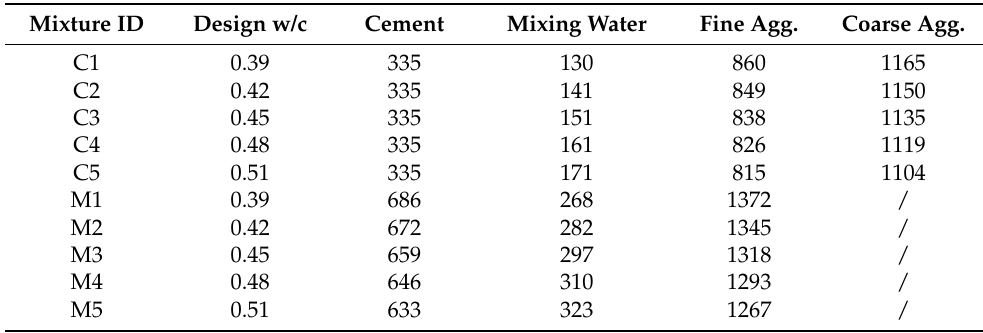
Table 2. SSD mixture proportions of cement mortar and concrete (kg/m 3